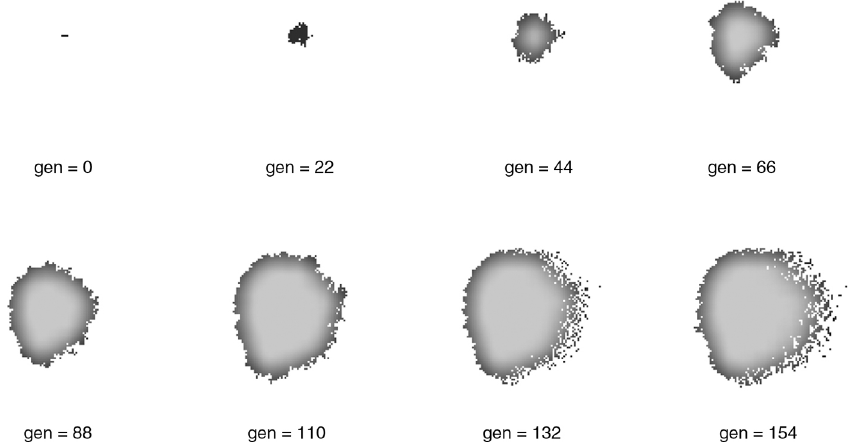
Figure 1: Evolution of a tumor model simulation assuming the parametric load shown in Table 1 for a tissue domain of 128 × 128 cells and 154